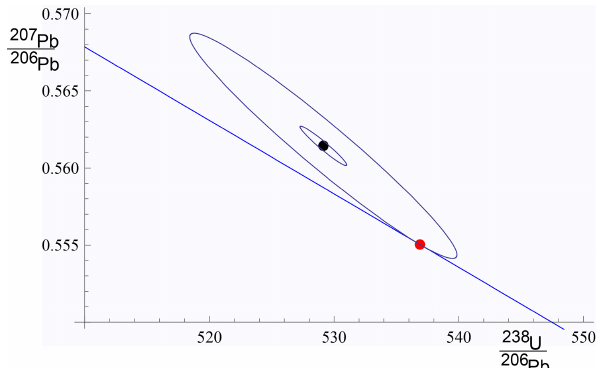
Figure 2. For an example data point, { x k ,y k } , the inner ellipse is calculated with the analytical uncertainties, V k , at the 1 σ level (in black). Given a line, y = a + bx (in blue), the ellipse must be drawn at the | r k | σ level (in red) to touch the line, in this case | r k | = 5 . 73. The data point is x k = 529 . 14, y k = 0 . 5614, and = 1 . 870, σ y = 0 . 00127, and ρ x = − 0 . 967. The line is y = σ x k k k y k